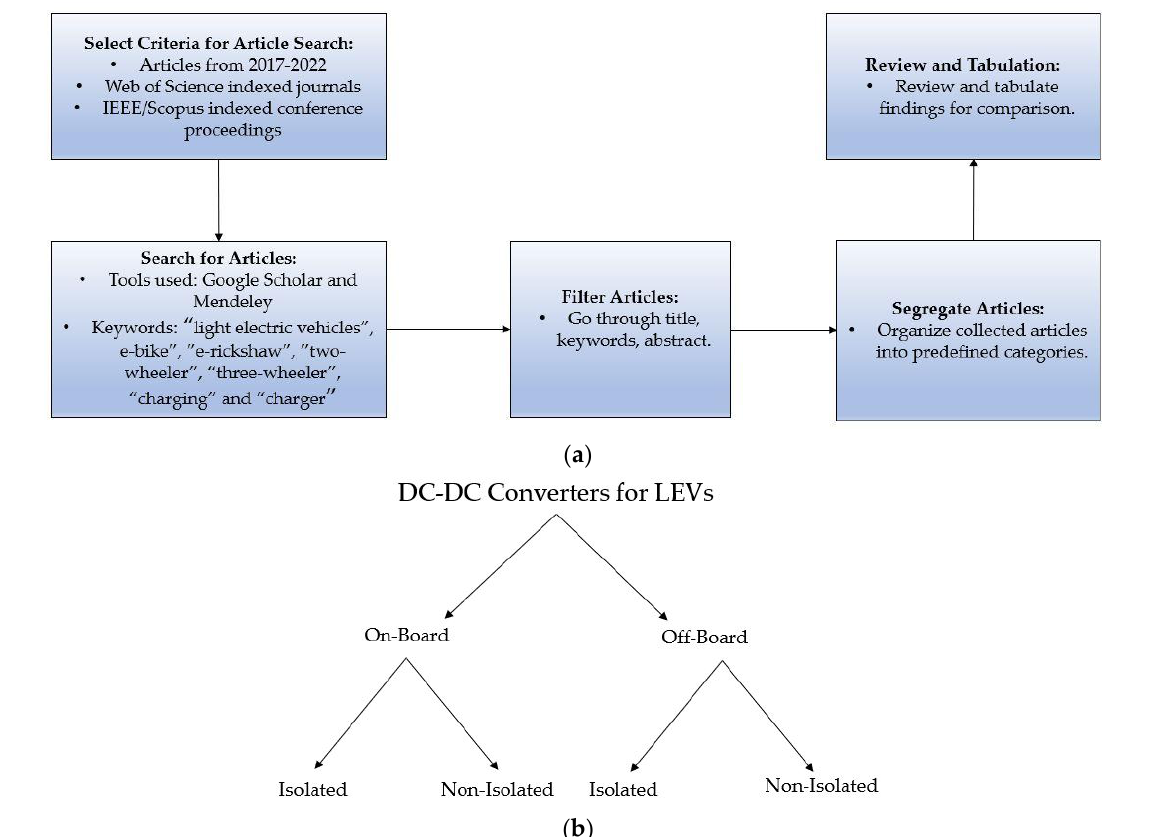
Figure 4. ( a ) Methodology workflow for this review study ( b ) Hierarchy for segregation of collected articles.